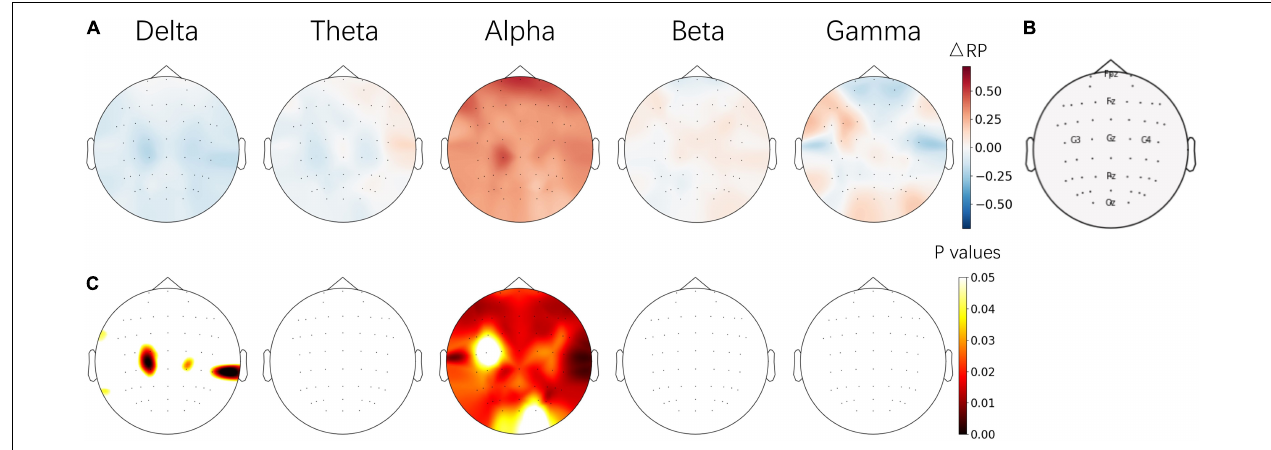
FIGURE 4 | (A) Topographical images of (cid:49) RP between the pre- and post-NFT baseline sessions from 5 frequency bands. (B) Position of electrodes. (C) The significant level of (cid:49) RP from paired t -test – the p values of electrodes were corrected by FDR. The images in (A,C) share the same color bars on the right, respectively.